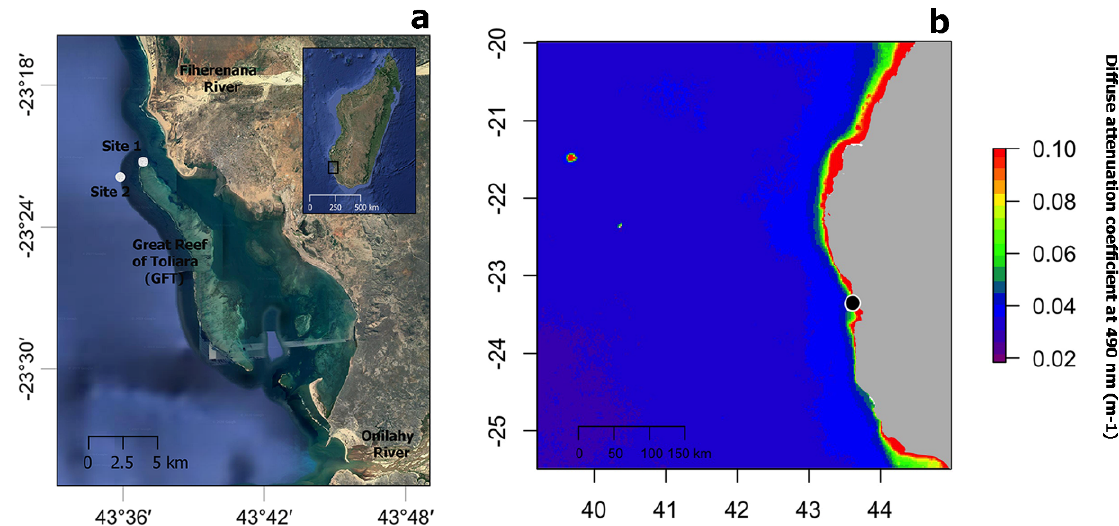
Figure 1. ( a ) Map showing the location of study sites 1 and 2 (white circles) near the Great Reef of Toliara (GRT) in SW Madagascar. ( b ) Annual median of the diffuse attenuation coefficient for downwelling irradiance at 490 nm in m − 1 (K d 490) for the year 2018 over the wider region (black circle indicated the location of the GRT). Satellite data derived from MODIS-Aqua accessed through OceanColor (https://oceancolor.gsfc.nasa.gov, accessed on 2 April 2019). Increasing coefficient values indicate higher water turbidity.